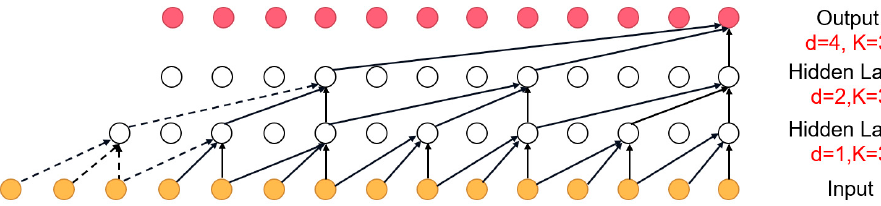
Figure 1. Dilated causal convolution.